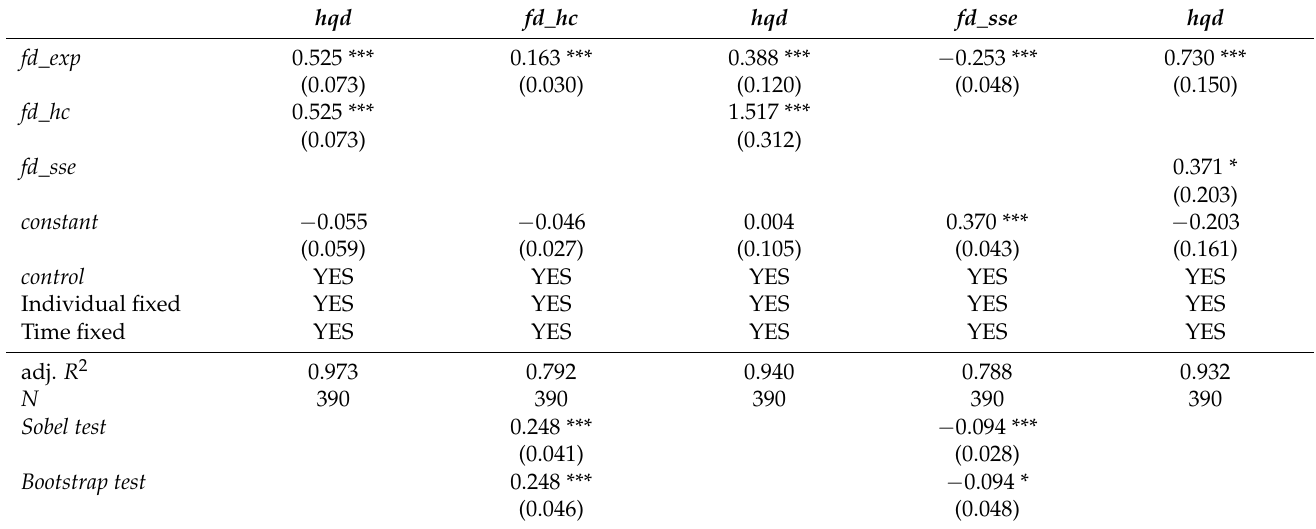
Table 7. The regression result of the mediating effect based on healthcare and social security employ- ment expenditure